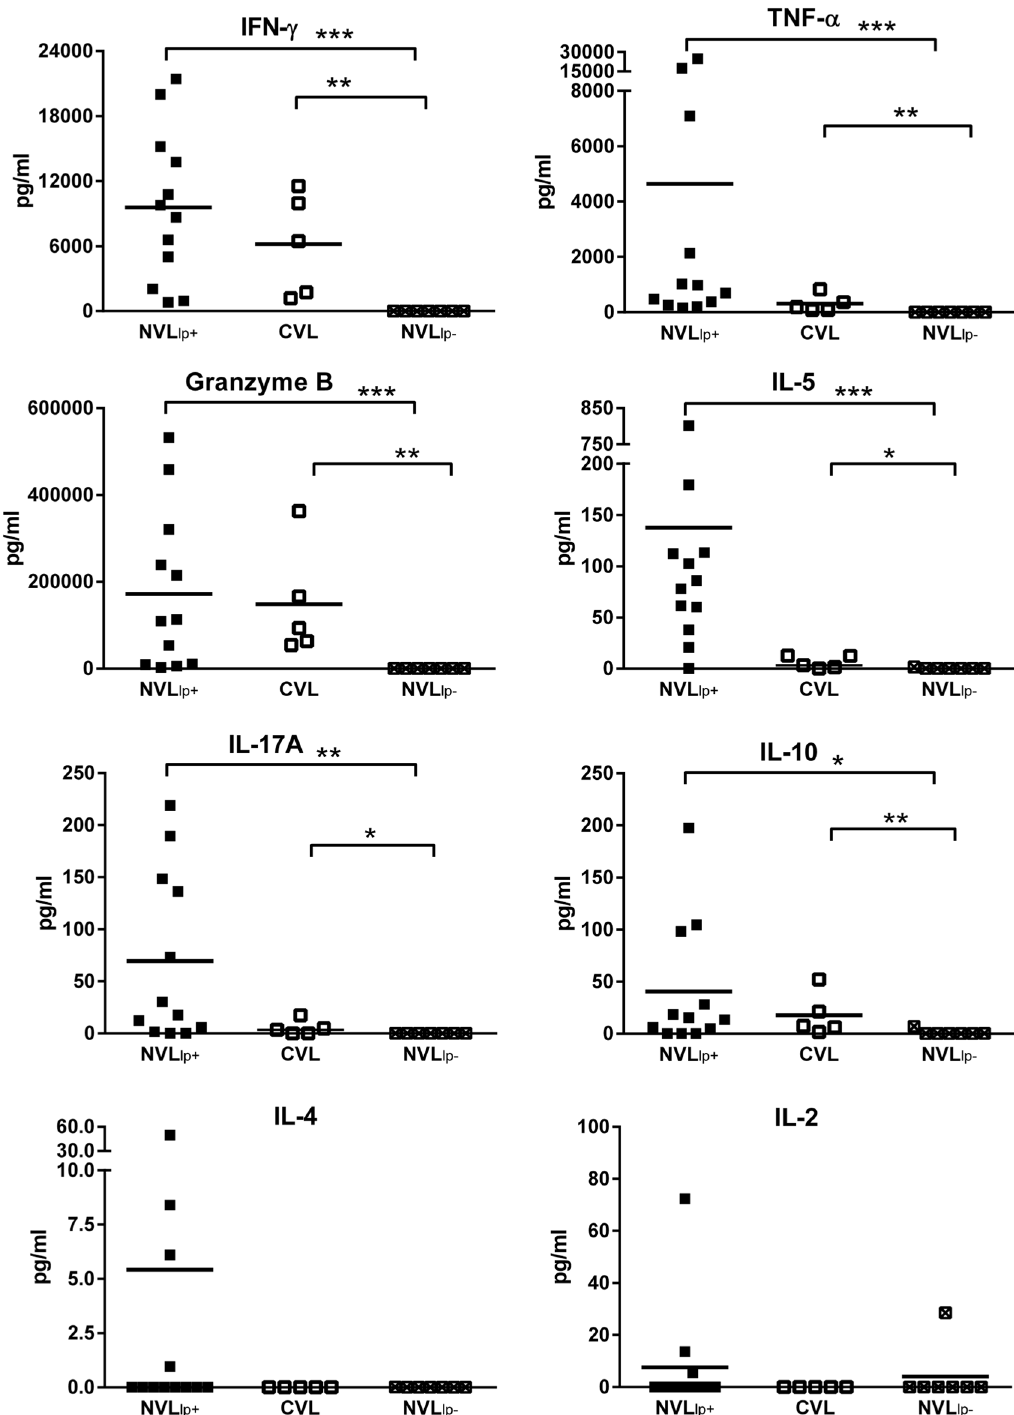
Fig 2. Cytokine and granzyme B production after PBMC stimulation with SLA for 5 days. IFN- γ , granzyme B, TNF- α , IL-10, IL-5, IL-17A, IL-2 and IL-4 concentrations (pg/ml) were measured in culture supernatants of 12 NVL lp+ subjects, 7 NVL lp- subjects, and 5 CVL subjects. * p < 0.05, ** p < 0.01, *** p <